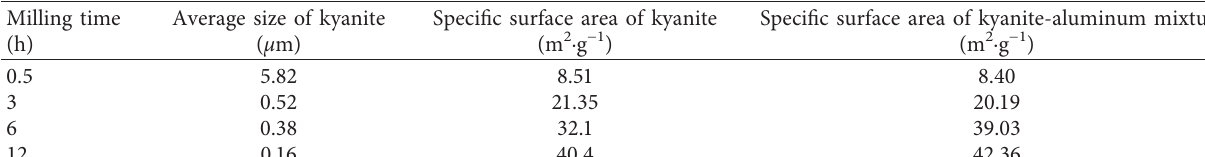
Figure 4: Particle size distribution of ground kyanite at different times. Table 2: Average size and specific surface area of kyanite raw and kyanite-aluminum mix.